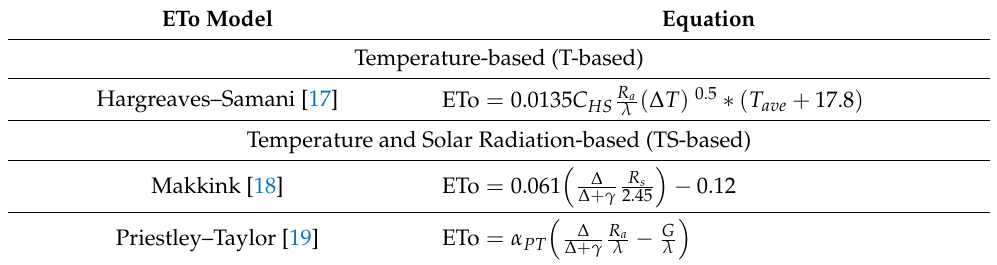
Table 2. Empirical equations for reference evapotranspiration